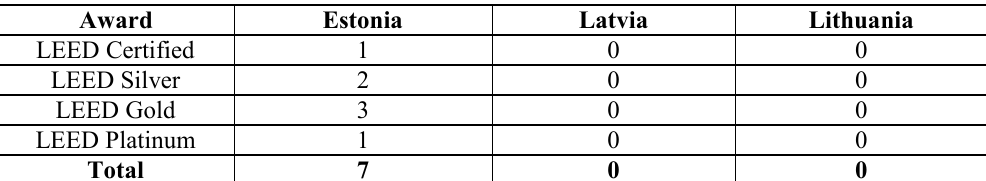
Table 4. LEED Projects (Developed by authors)